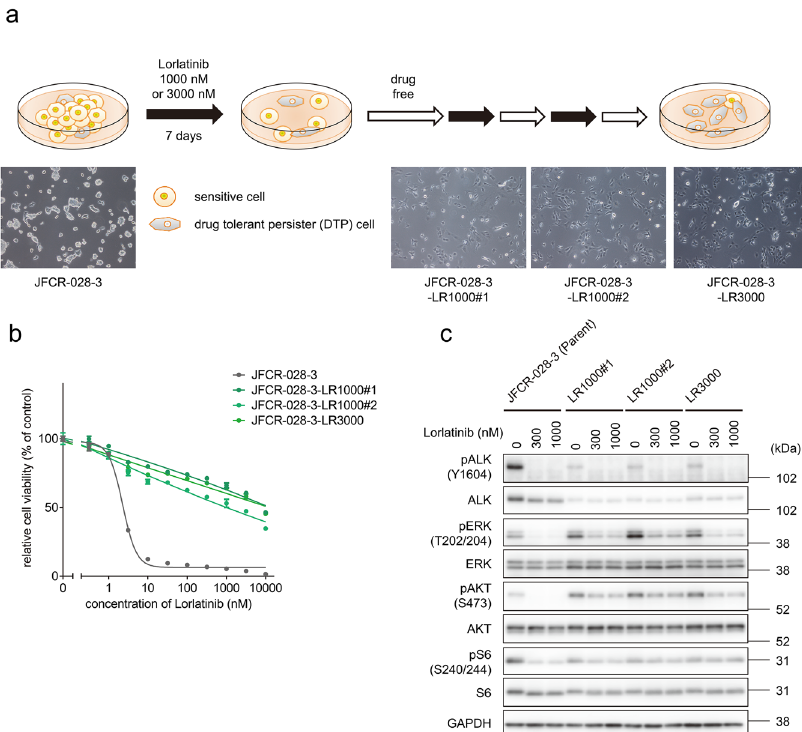
Fig. 1 Lorlatinib intermediate resistant cells derived from JFCR-028-3 parental cells showed intermediate resistance to lorlatinib. a Schematic of the work fl ow to establish lorlatinib intermediate resistant cells from JFCR-028-3 parental cells, established after three cycles of drug treatment and a drug holiday. Scale bar = 100 μ m. b Cell viability of JFCR-028-3 parental and lorlatinib intermediate resistant cells ( n = 3). Each point represents the mean ± SD of three replicates. c Western blot analysis showing suppression of phospho-ALK and its downstream signaling in JFCR-028-3 parental and lorlatinib intermediate resistant cells treated with indicated concentrations of lorlatinib for 3 h. GAPDH was used as a loading